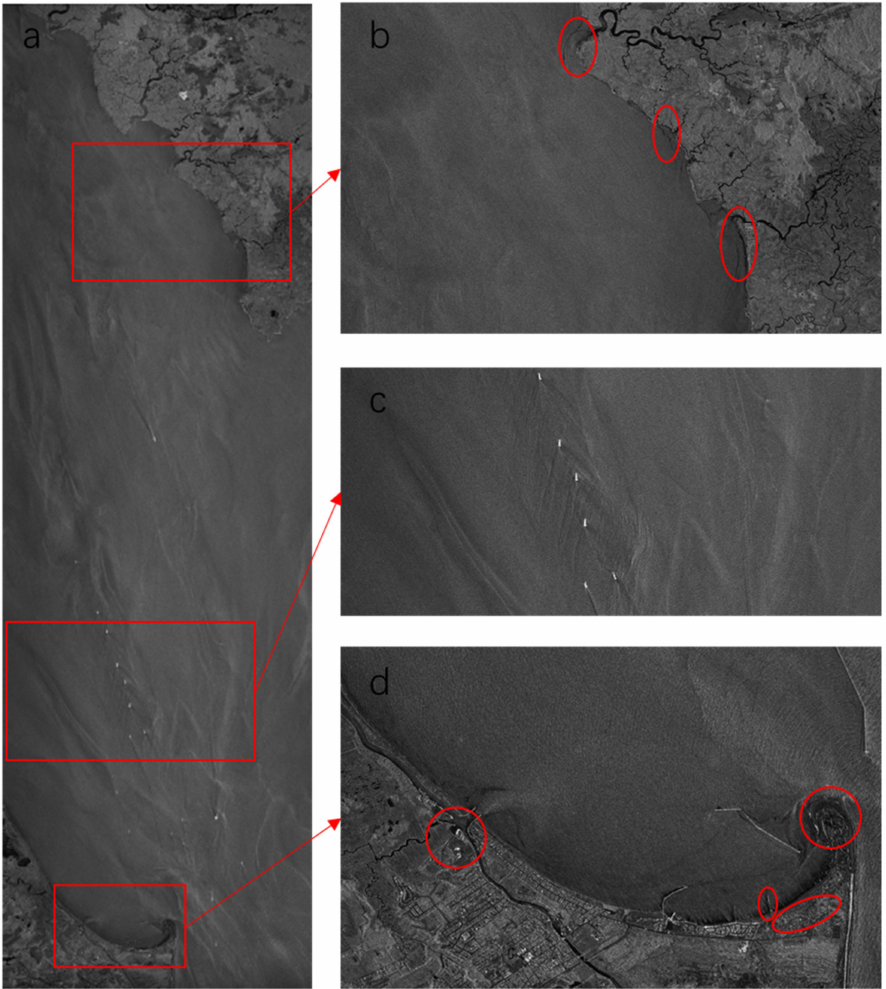
Figure 5. Image of Delaware Bay obtained by striping mode. ( a ) Whole SAR image of Delaware Bay whose gridding size is 13,996 × 44,480 (horizontal × vertical) and spatial resolution is 3 m. ( b ) Enlarged view in the top rectangle area in Figure 1a as the arrow points. ( c ) Enlarged view in the middle rectangle area in Figure 1a as the arrow points. ( d ) Enlarged view in the bottom rectangle area in Figure 1a as the arrow